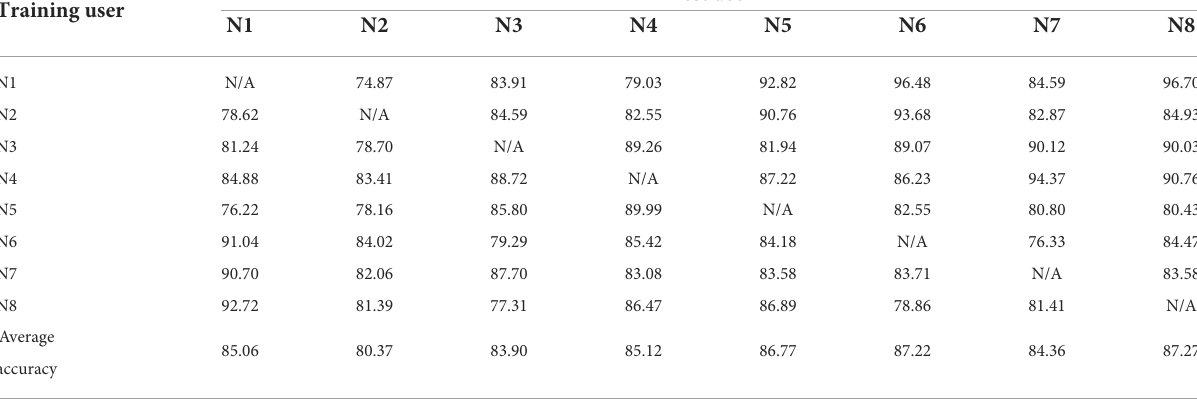
TABLE 5 Experimental results for user-independent CCA-OT framework (the sEMG data of all test users were reduced randomly by two channels). Training user